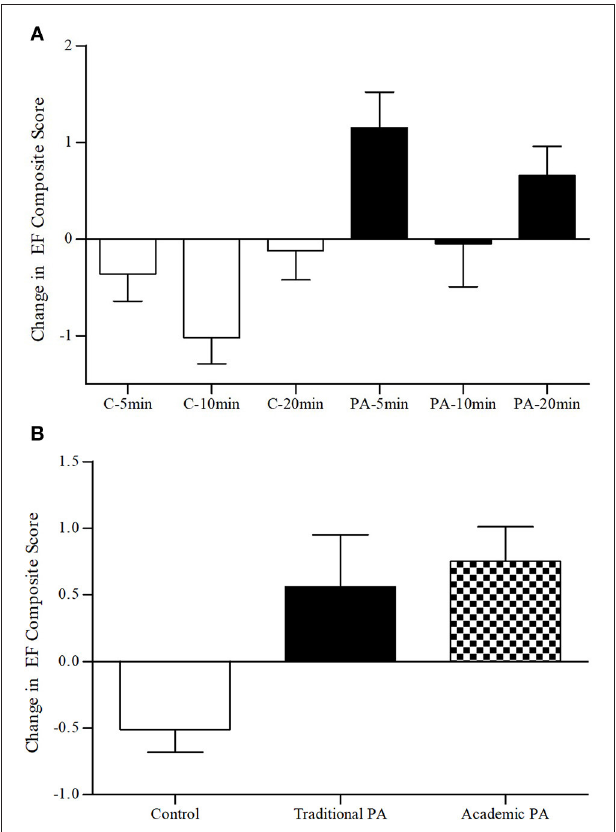
FIGURE 4 | (A) Change in executive functioning composite scores by activity type and dose. (B) Change in executive functioning composite scores by activity type. EF, executive functioning; C, sedentary control; PA, physical activity break; min, minutes. Error bars represent SE of the mean.